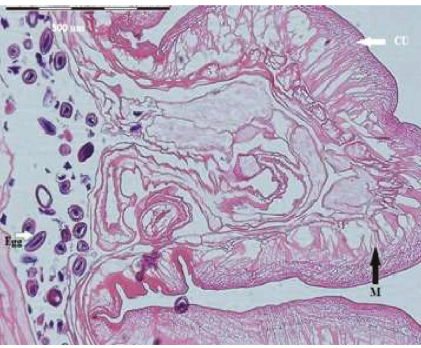
Figure 2: Section of Macracanthorhynchus ingens H.E.-stained. Dentifiable in this image are the characteristic cuticle (CU), muscles (M), and